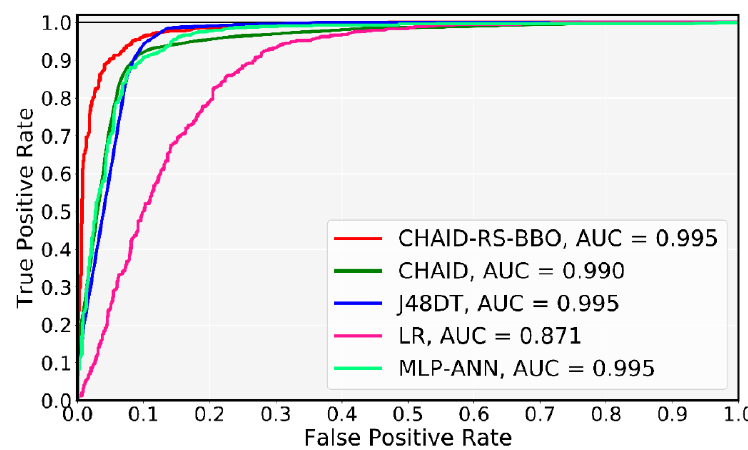
Figure 6. The ROC curve of the five flash flood models in the training phase.